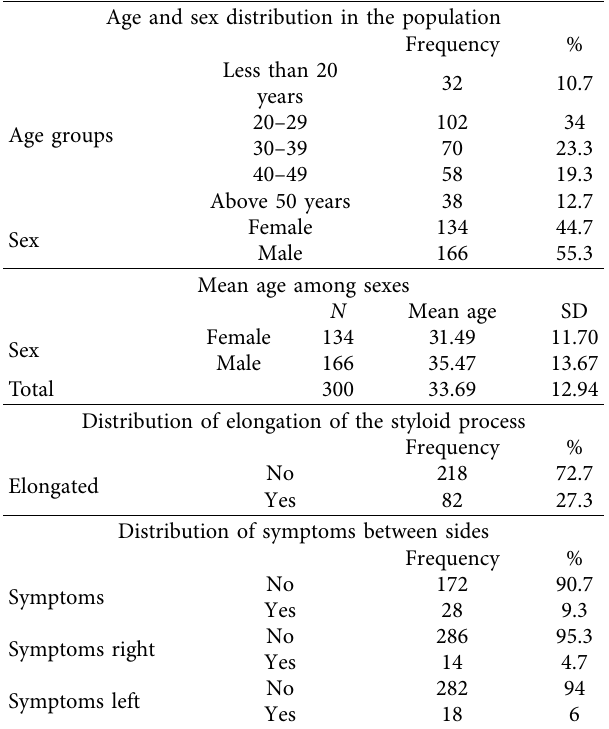
Figure 1: Measuring the elongated styloid process on both sides. Table 1: Characteristics of the study